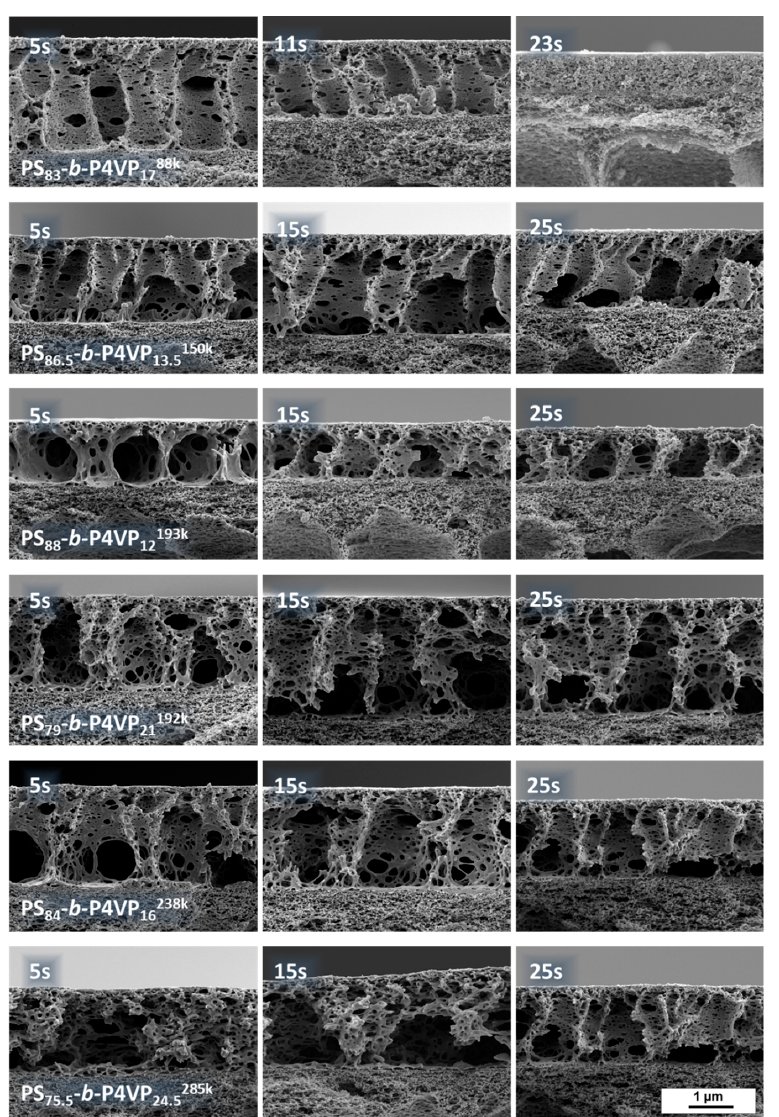
Figure A3. SEM cross-sectional view on PS- b -P4VP membranes of different casting solutions according to Table 1 with increasing evaporation time.